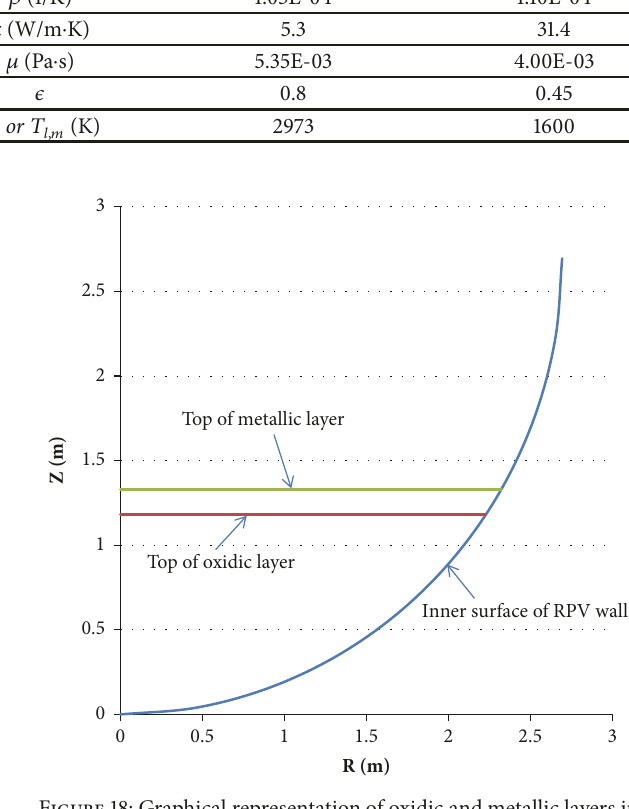
Figure 18: Graphical representation of oxidic and metallic layers in the